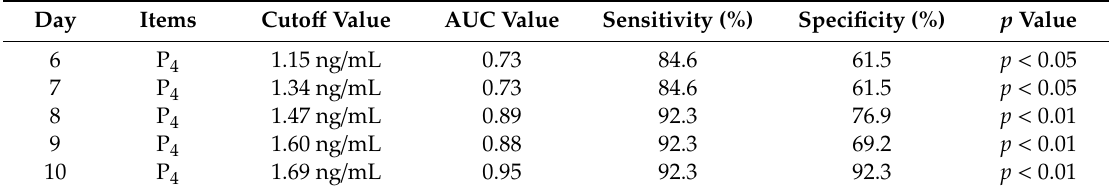
Table 3. Summary of the ROC analyses of the progesterone (P 4 ) levels from Day 6 to Day 10 post-TAI in bu ff aloes during the transitional